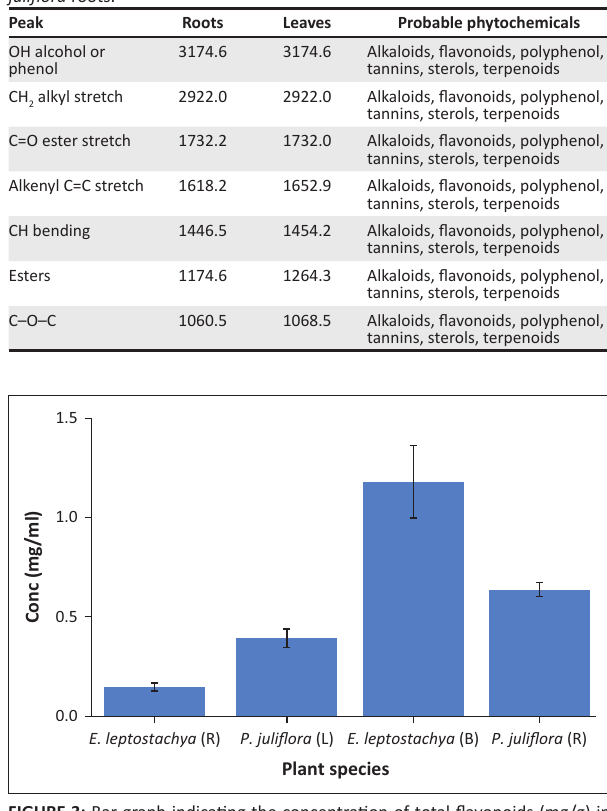
FIGURE 3: Bar graph indicating the concentration of total flavonoids (mg/g) in Entada leptostachya and Prosopis juliflora extracts.